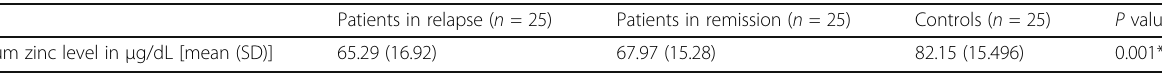
Table 3 Serum zinc level in MS patients and control group Patients in relapse ( n = 25)